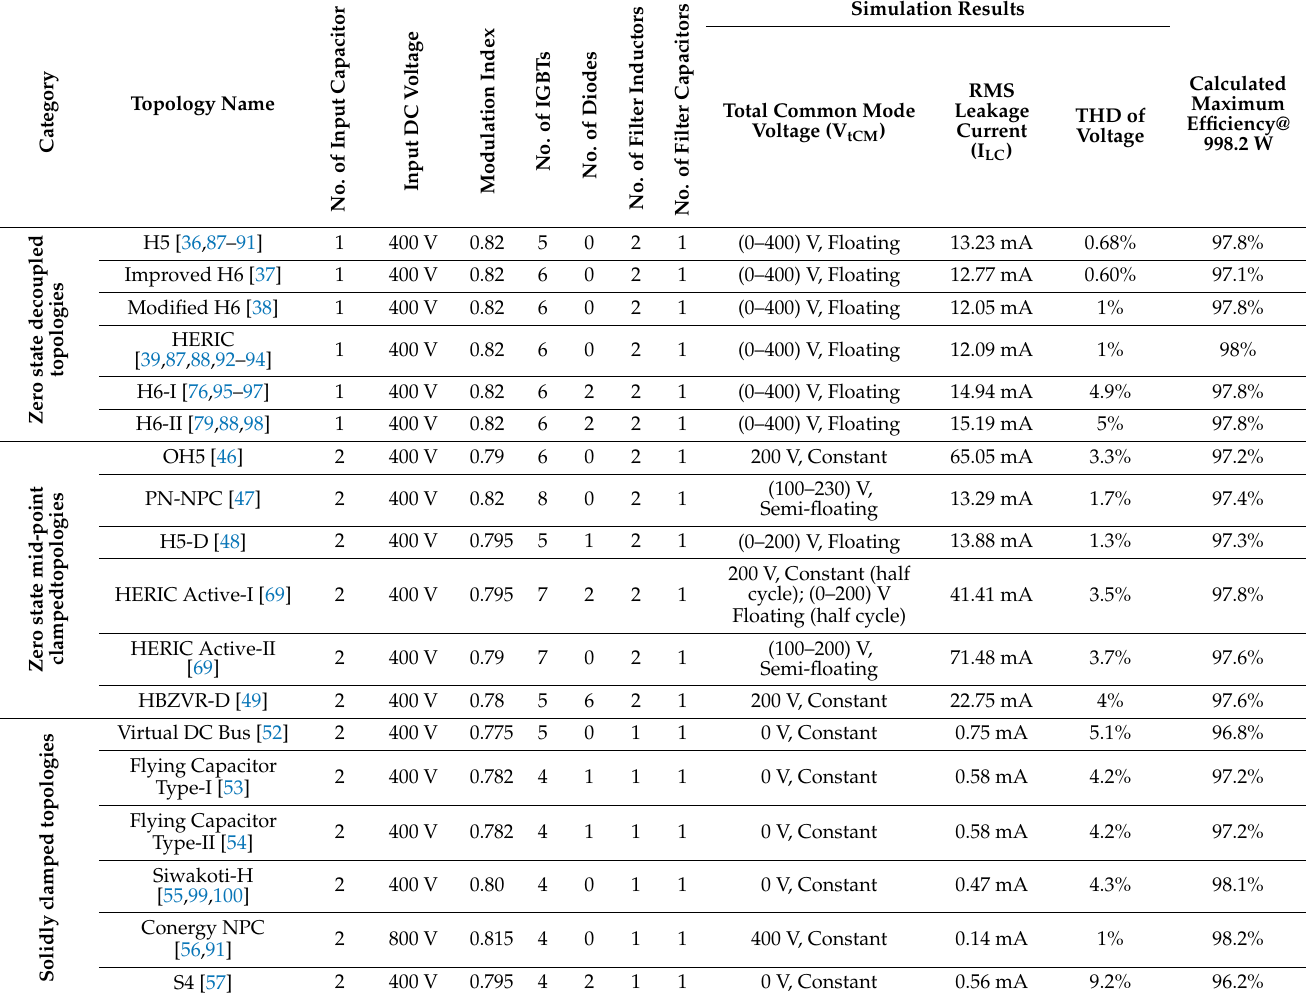
Table 4. Comparison of the selected topologies based on simulation results and physical